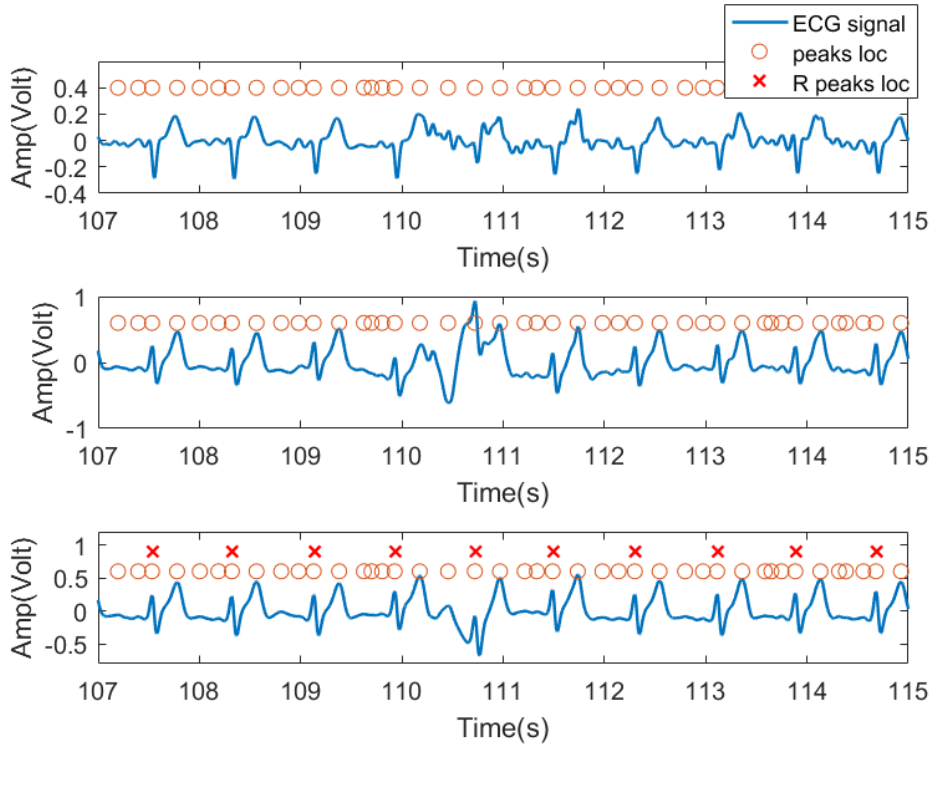
Figure 8. Data segment diagram. The blue curve is the ECG three-lead signal, and the orange circle represents the position of each signal segment intercepted by the point at the center with the left and right radius r, and the red X are the ground truth of R wave